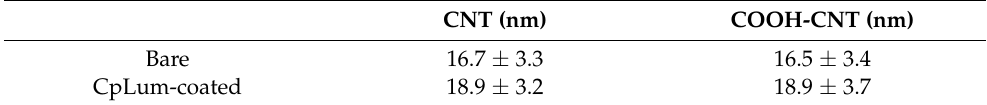
Figure 3. SEM micrographs of ( a ) CNT, ( b ) CpLum/CNT, ( c ) COOH-CNT and ( d ) CpLum/COOH- CNT. Table 2. Diameters of the CNT samples measured from SEM micrographs.